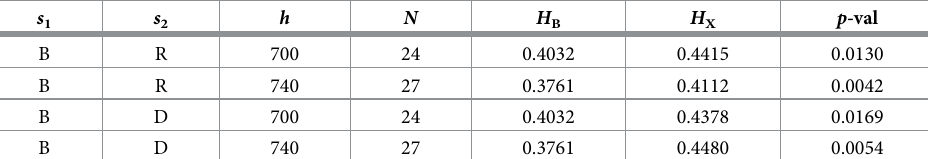
Table 5. Estimated Hurst exponent values from verification dataset. h = 700 for 500 μ s signals corresponds to h = 1750 for 200 μ s